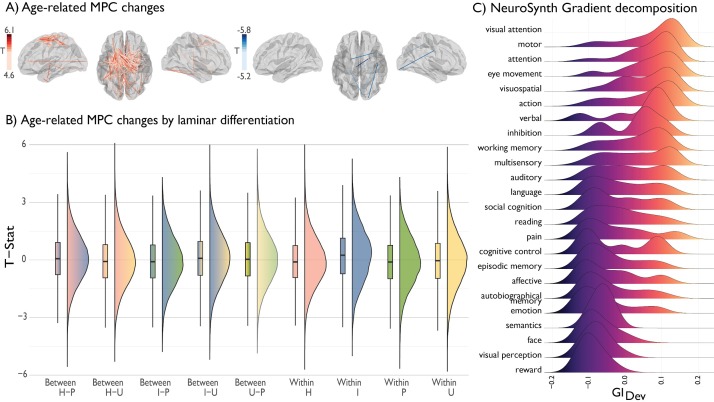
Deconstructing age-related changes in MPC.(A) Age-related changes in MPC stratified by increases (red) and decreases (blue). (B) Edge-wise changes in MPC were stratified by level of laminar differentiation. Raincloud plots illustrate the range of t-statistic values within and between different classes. Lines depict the 25%, 50% and 75% quartiles. I = idiotypic. U = unimodal. H = heteromodal. p=paralimbic. (C) Ridgeplot depicting distribution of thresholded (z > 2) gradient values across NeuroSynth composite terms, ranked from high to low mean value.